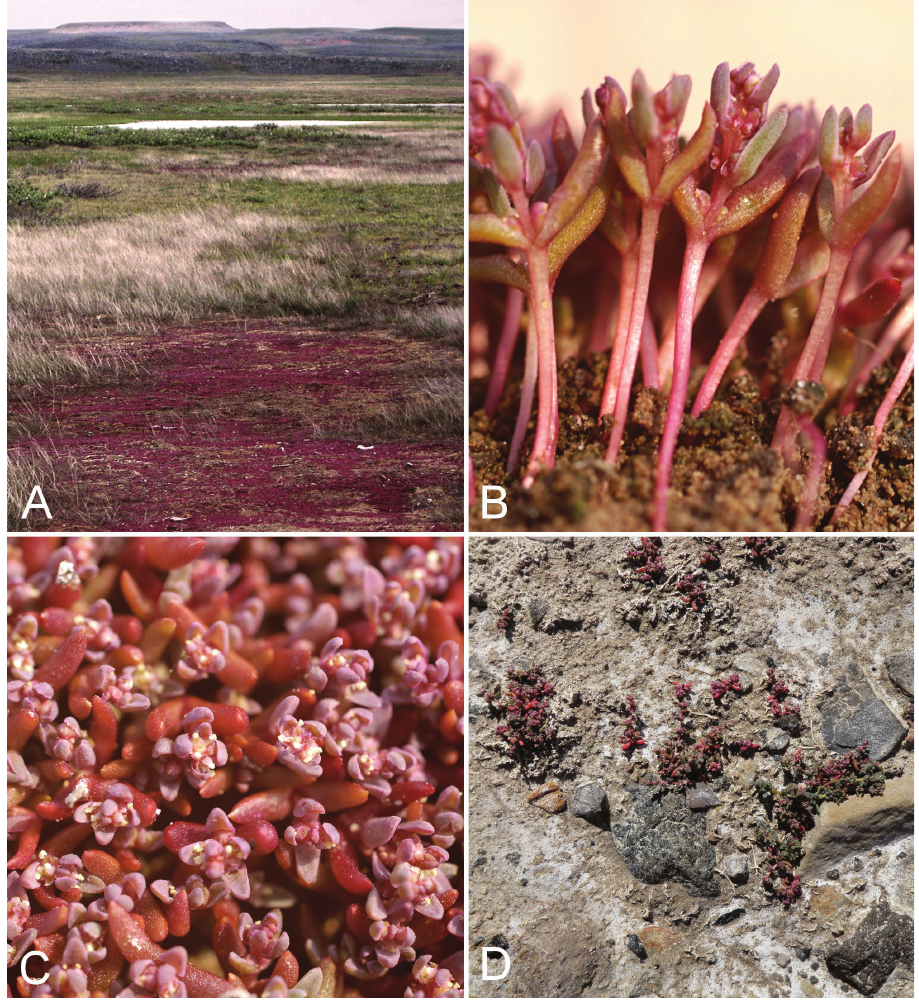
Figure 11. Suaeda calceoliformis : A habitat B habit, profile C inflorescences, Gillespie et al. 8068 D habit, Gillespie et al. 10243 . Photographs by R.D. Bull ( A, B, C ), L.J. Gillespie ( D